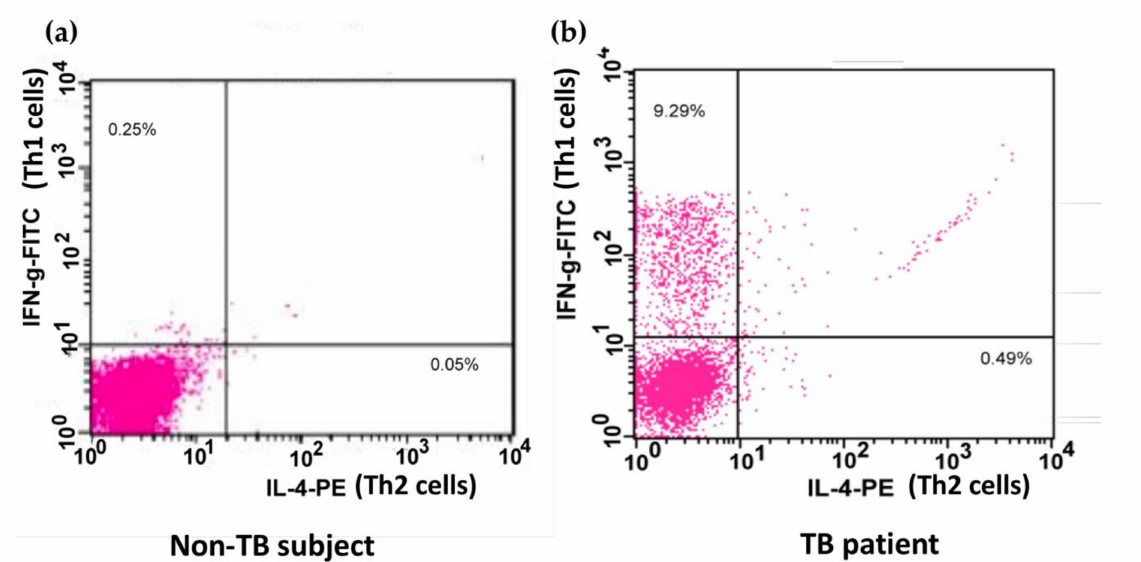
Figure 1. Flow cytometric analysis of Th cells. A demonstration of the expression of IL-4 and IFN- γ on phorbol myristate acetate and ionomycin-stimulated peripheral blood CD4 + Th cells from one non-TB subject ( a ) and one patient infected with TB ( b ). Peripheral blood mononuclear cells were stained with PerCP-conjugated anti-Leu-3a/CD4 antibody, FITC- conjugated anti-INF- γ antibody, and PE-conjugated anti-IL-4 antibody or the respective isotype IgG controls. The expression of IFN- γ and IL-4 on Th cells was identified by flow cytometry. Th, CD4 + T helper; TB, tuberculosis; PerCP, peridinin– chlorophyll protein; FITC, fluorescein isothiocyanate; PE, phycoerythrin; IL-4, interleukin-4; IFN- γ , interferon- γ